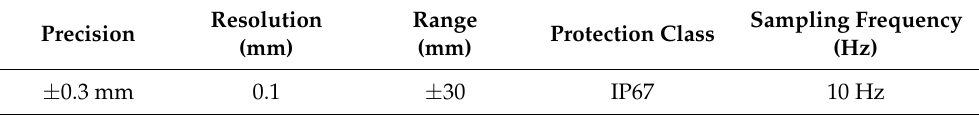
Table 6. Basic performance requirements parameters of laser displacement monitoring